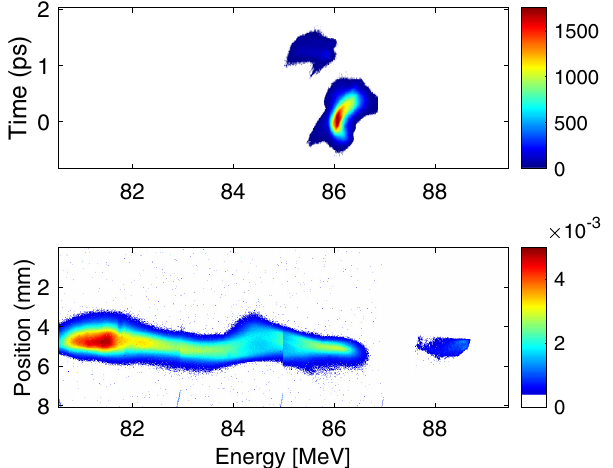
FIG. 2. Longitudinal phase space of the driver and witness bunches upstream (top) and bunch train energy spectrum down- stream of the plasma accelerator module (bottom). To reconstruct the energy-depleted spectrum of the driver after witness accel- eration, the bottom plot is obtained by merging several images acquired for different currents of the magnetic spectrometer.